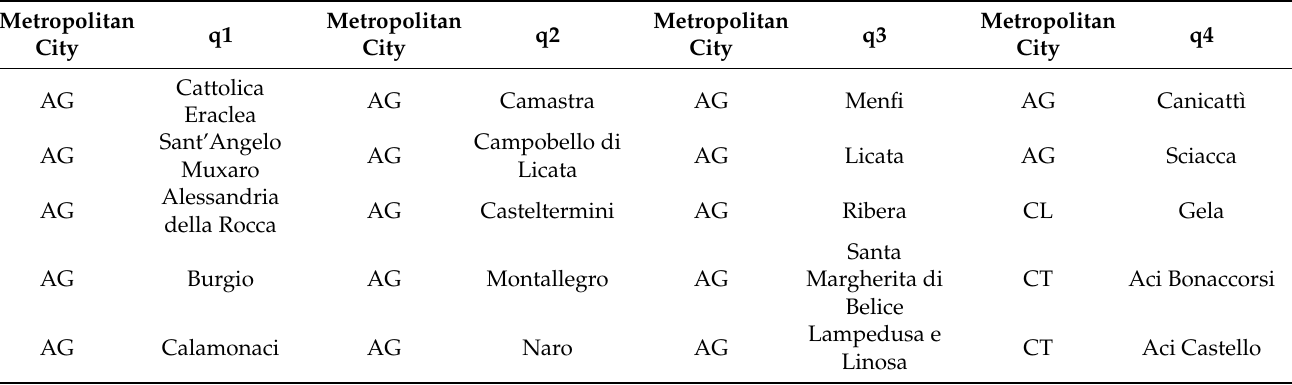
Table A3. Cluster of municipalities based on quartiles of the abandonment index for nine metropolitan cities in